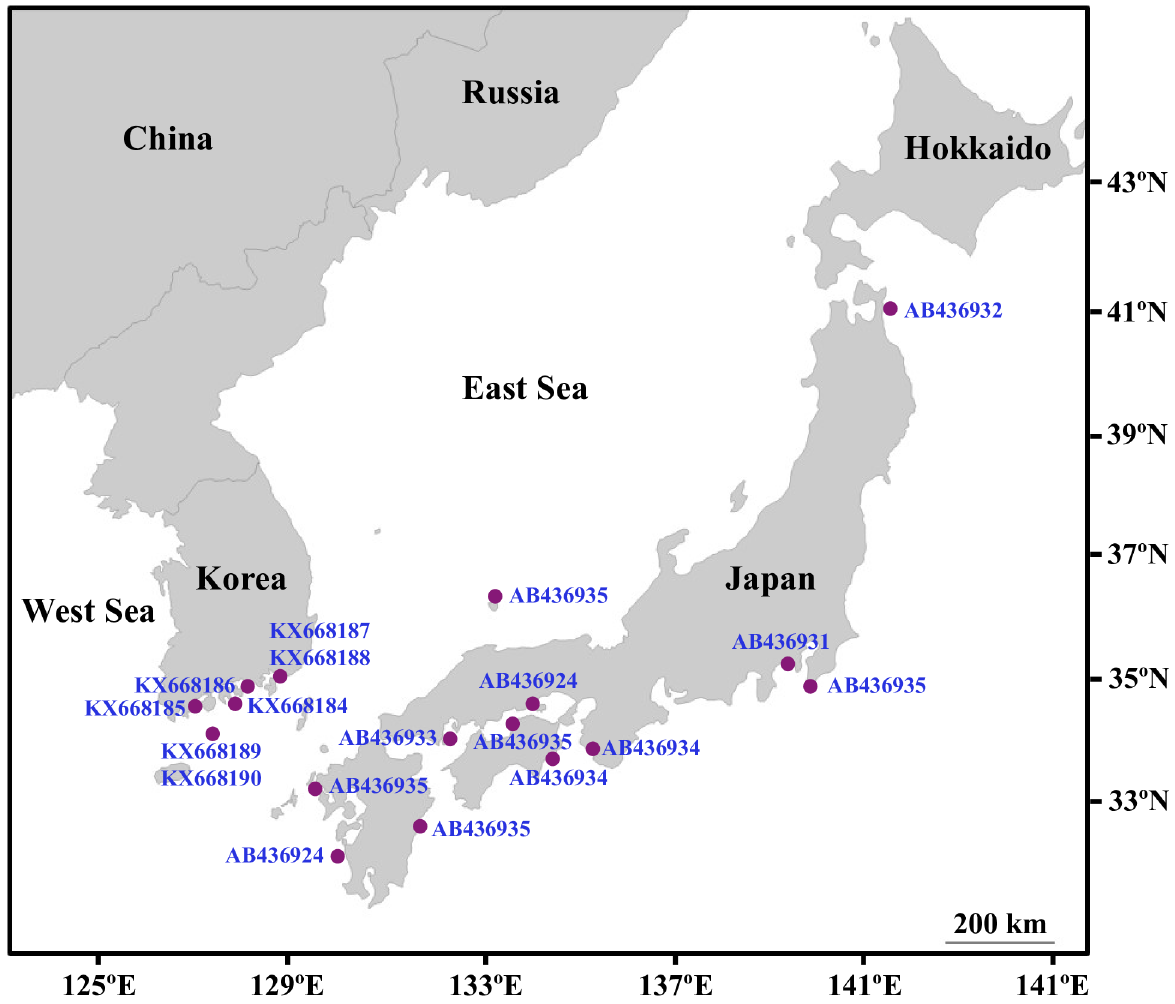
Fig 1. Halophila nipponica populations in the temperatewaters of Korea and Japan. Geographical locationsfor H . nipponica populations in Japanesewaters were obtained from Uchimuraet al.